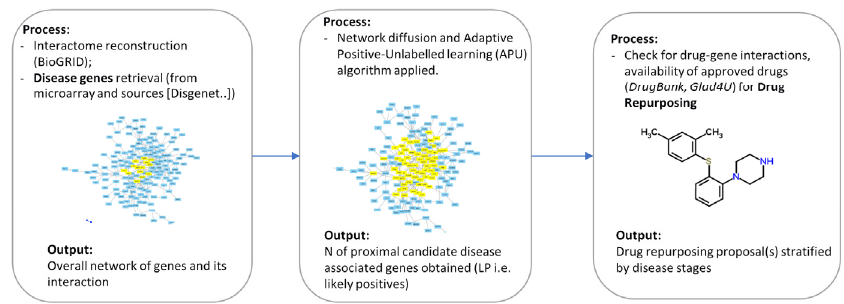
Figure 4. Computational workflow diagram (image adapted from [22]).